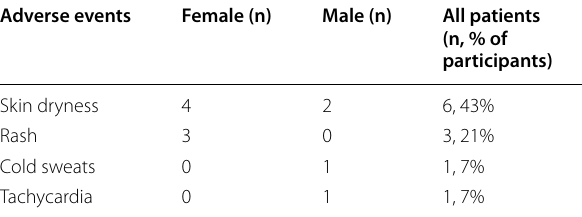
Table 2 Complete list of all reported adverse events in the study. Data are subdivided by the type of adverse effect. The adverse effects are ranked from most to least commonly reported. These data are presented from the 14 participants who completed the study. The n represents the raw number of subjects. The percentage was calculated from the 14